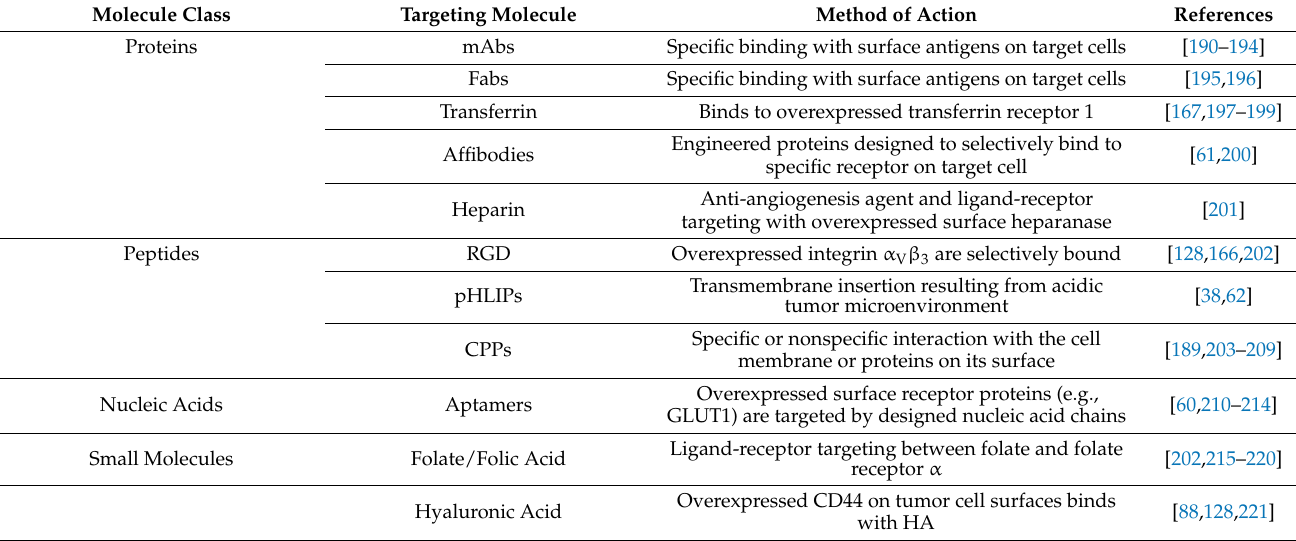
Table 2. Active Targeting Molecules Used with